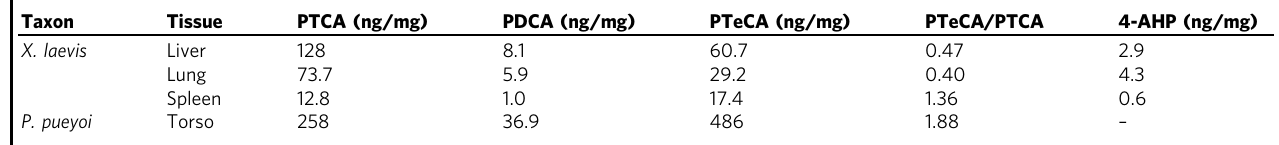
Table 1 AHPO quanti fi cation of melanin markers in extant and fossil frogs Taxon